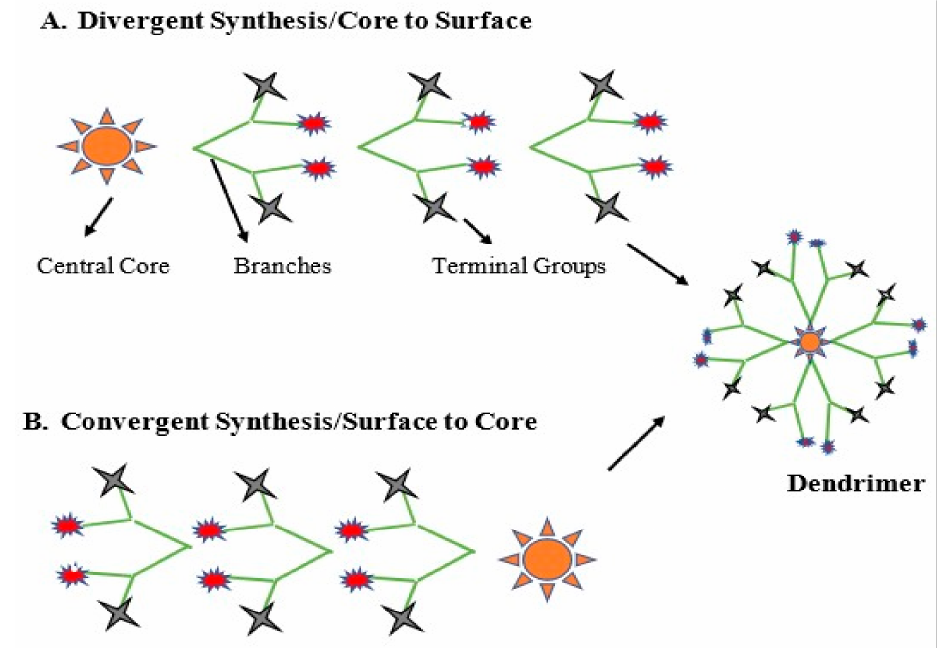
Figure 1. The construction of dendrimers: two main architectural methods